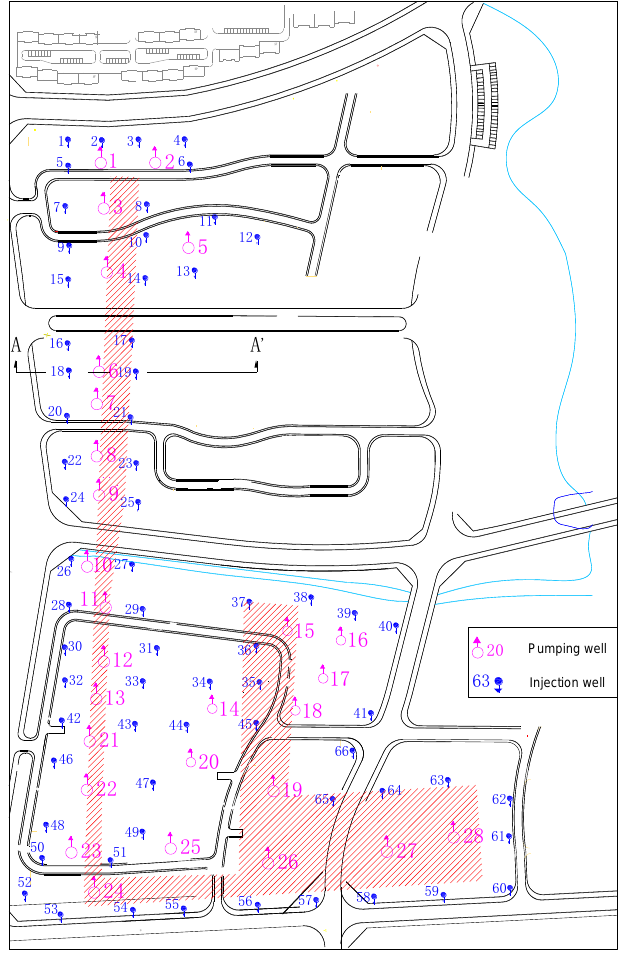
Figure 5. The contamination plume and locations of pumping and injection wells.